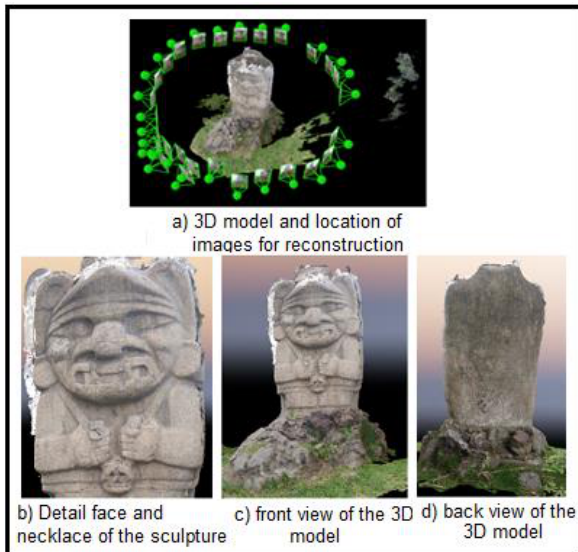
Figure 11. Three-dimensional model sculpture San Agustín No.28.